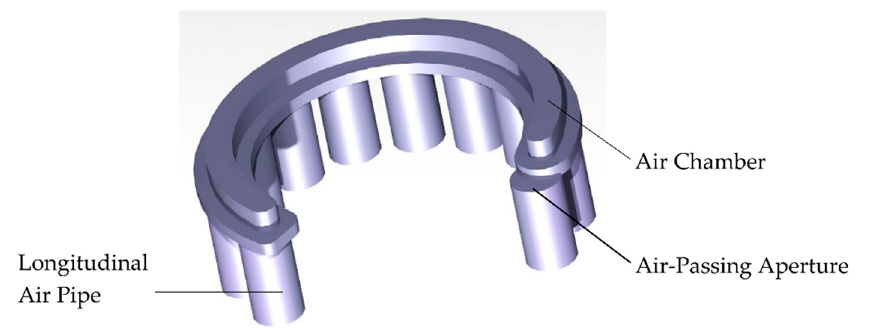
Figure 5. Air chamber confluence area.